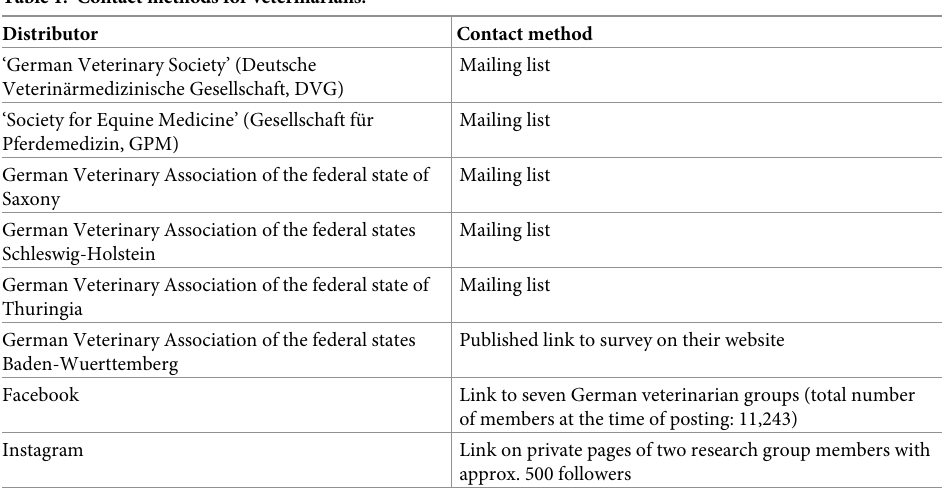
Table 1. Contact methods for